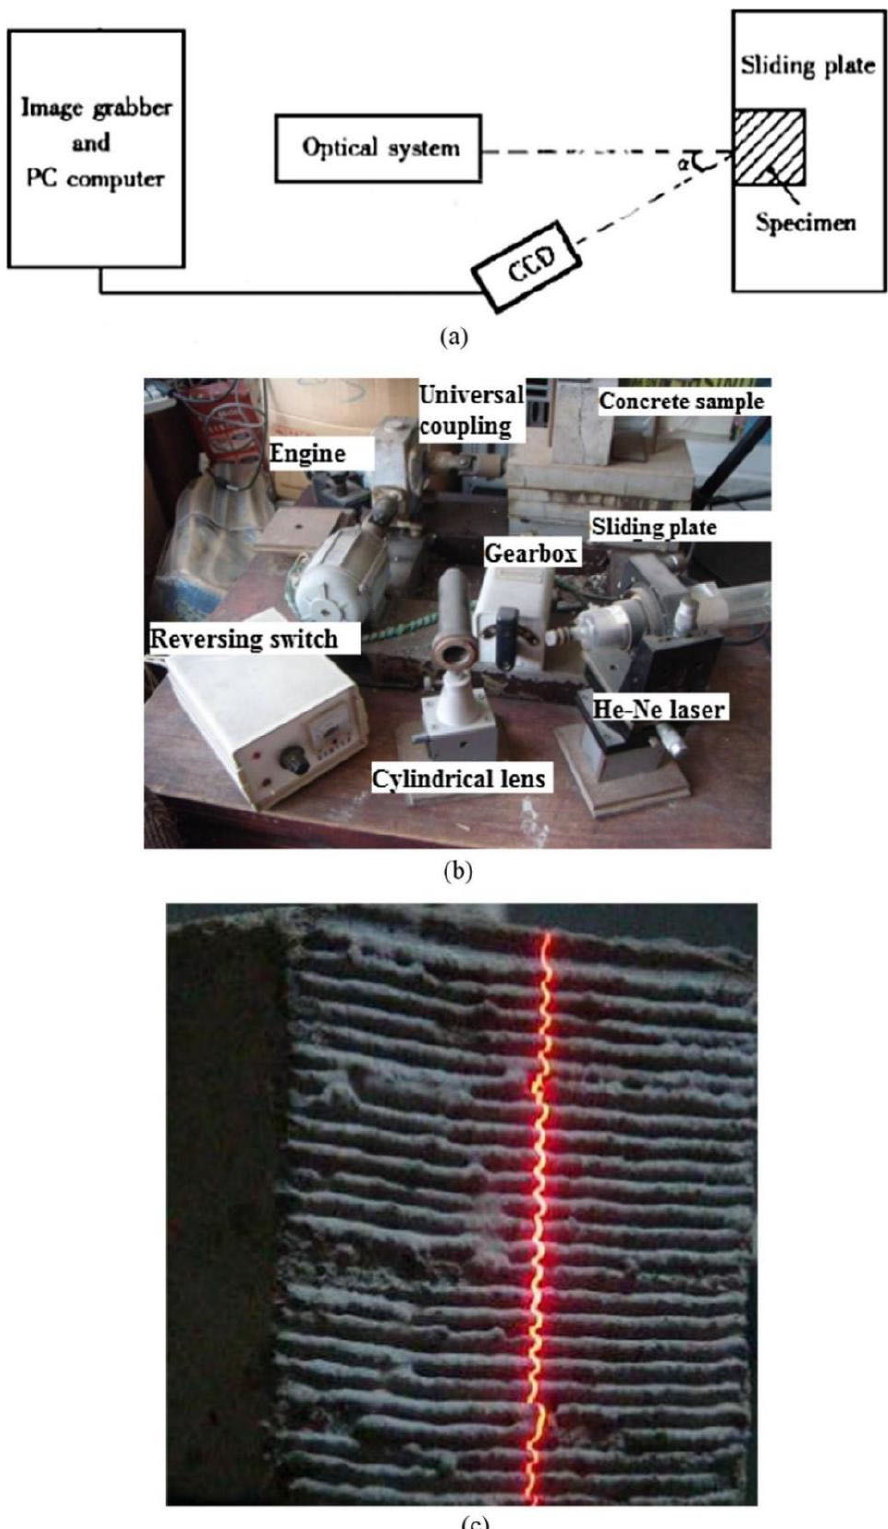
Figure 10. Laser triangulation method to quantified the surface roughness of concrete substrate to be repaired. ( a ) Schematic diagram of laser triangulation ranging test apparatus; ( b ) Installation diagram of laser triangulation ranging test apparatus; ( c ) 3D image of the concrete surface [67]. (Adapted and reprinted with permission from ref. [67], © 2017, Construction and Building Materials .).